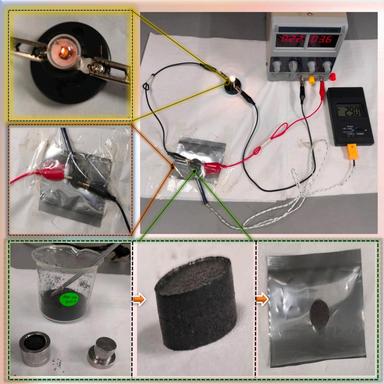
Schematic diagram generating Light with Diode Connection to SS-PCM (A70 + EG).